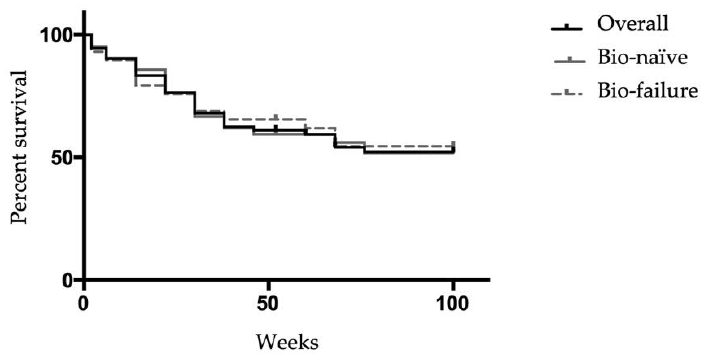
Figure 3. Kaplan–Meier plots for relapse-free survival of patients treated with Vedolizumab up to 100 weeks after administration. (Overall n = 51, bio-naïve n = 25, bio-failure n = 26). Relapse-free survival was assessed using the Kaplan–Meier method.